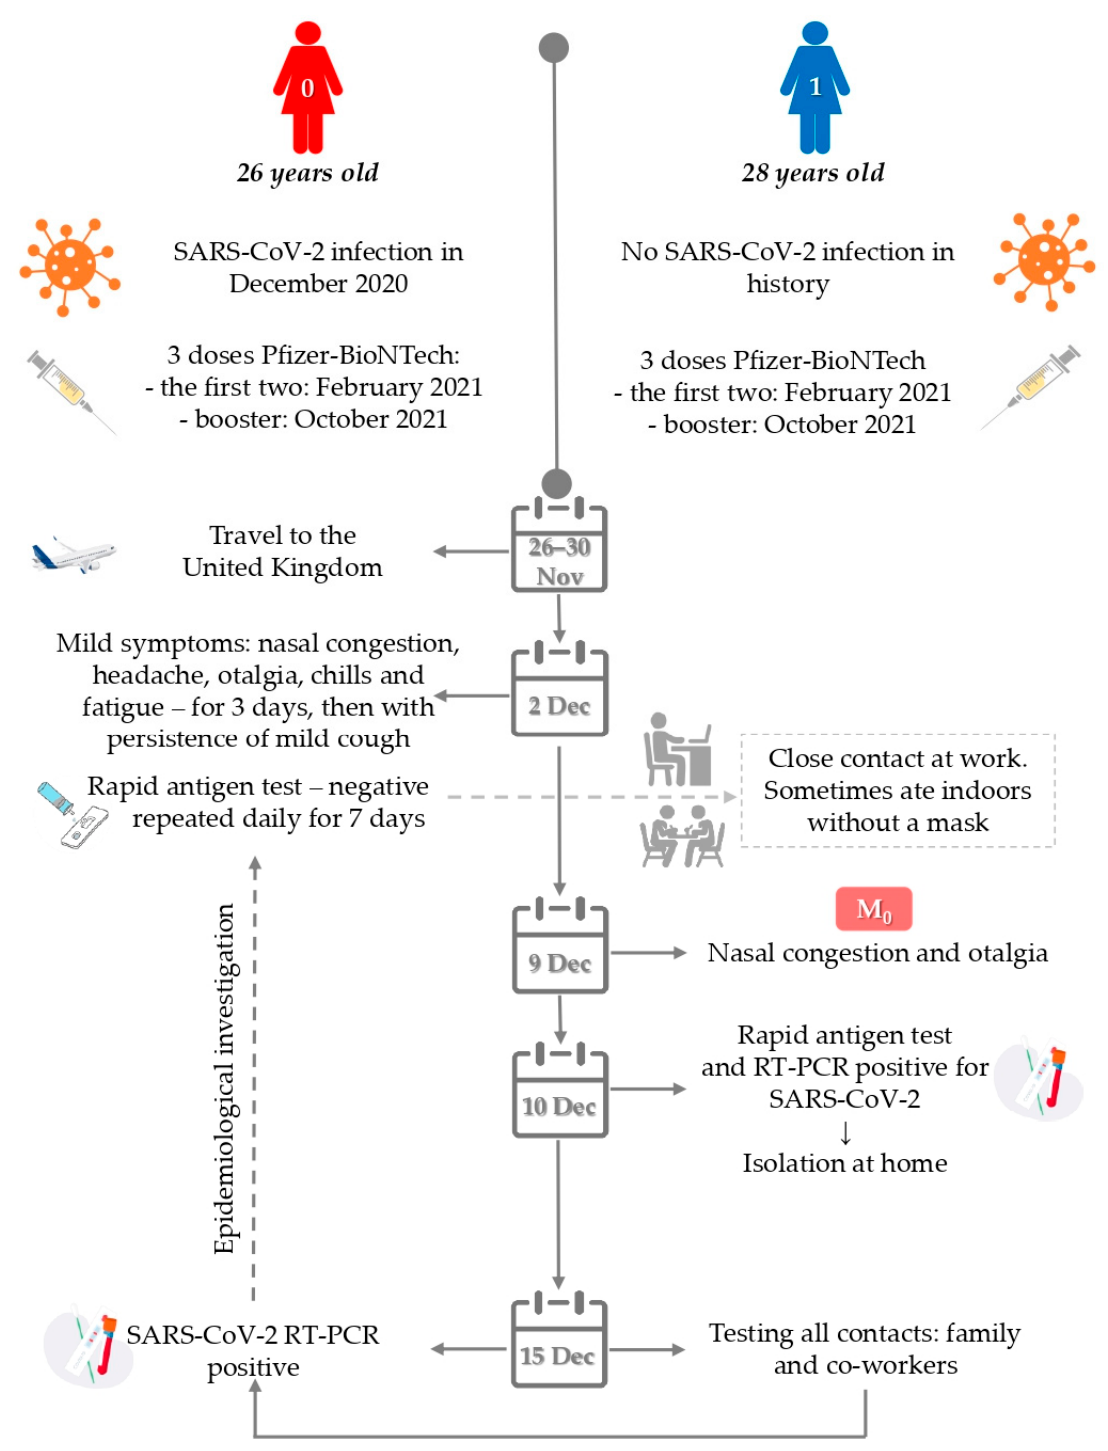
Figure 1. Timeline of epidemiological investigation. M 0 -the trigger for the start of the epidemiological investigation.